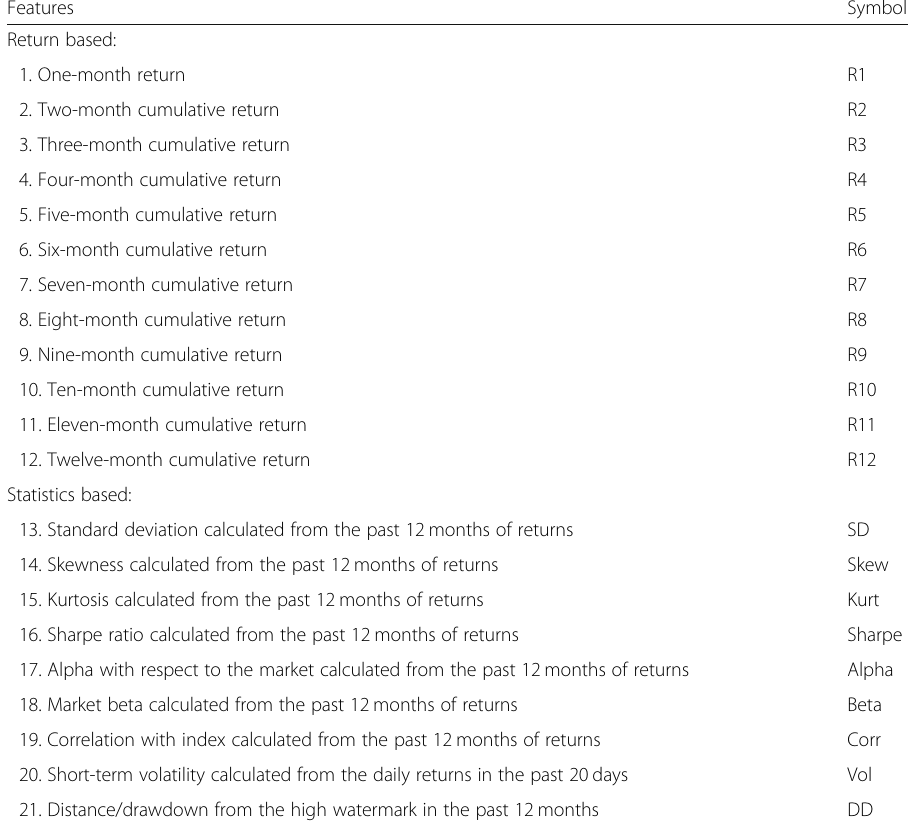
Table 1 Features used in the study Features